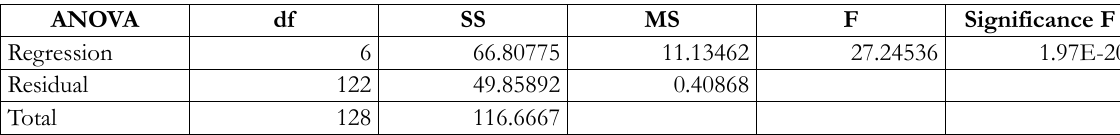
Table 14. Analysis of variance for Incentives for lecturers and students against increased usage of ICTs